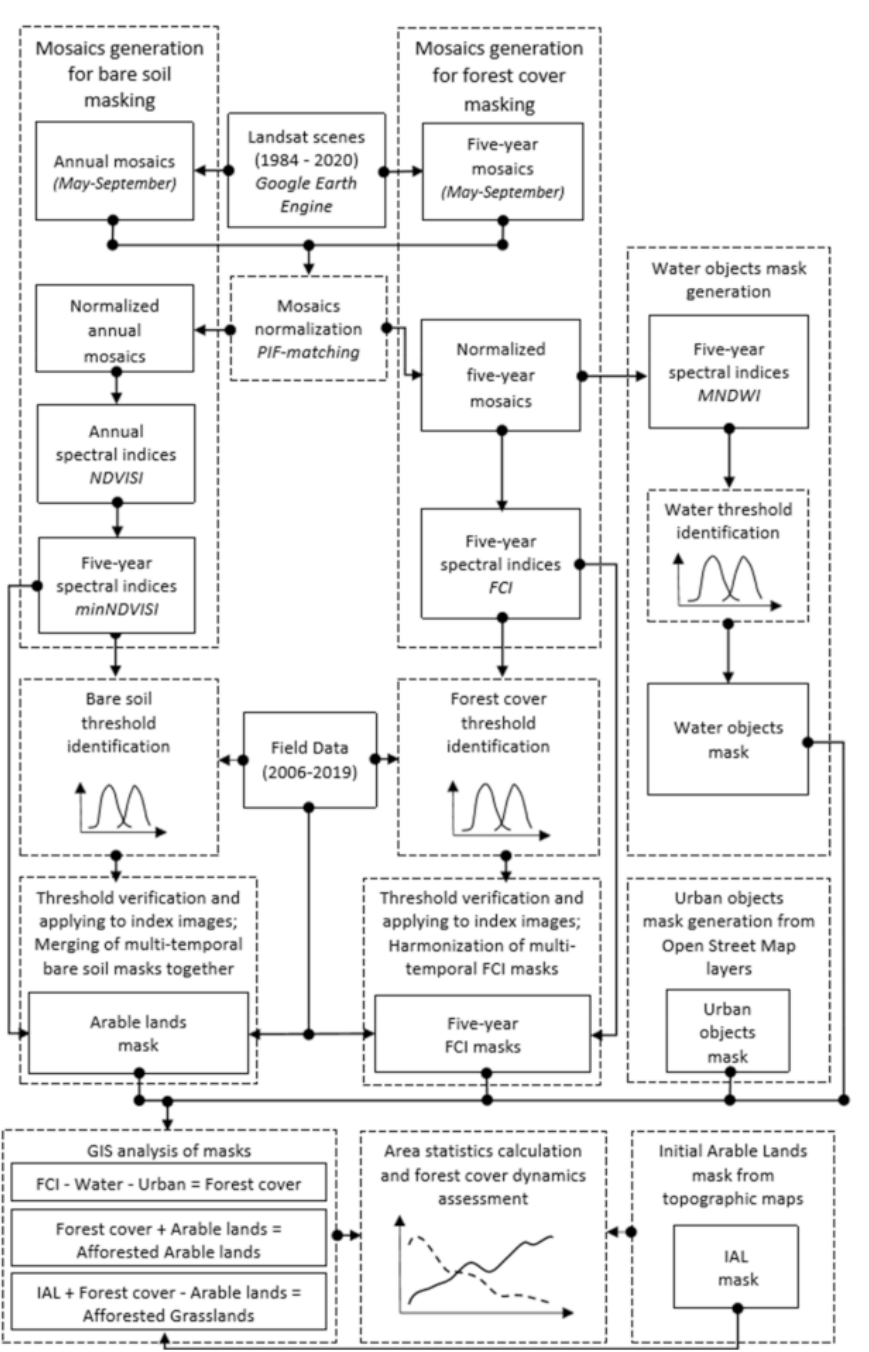
Figure 2. Flowchart of data processing methods used in the